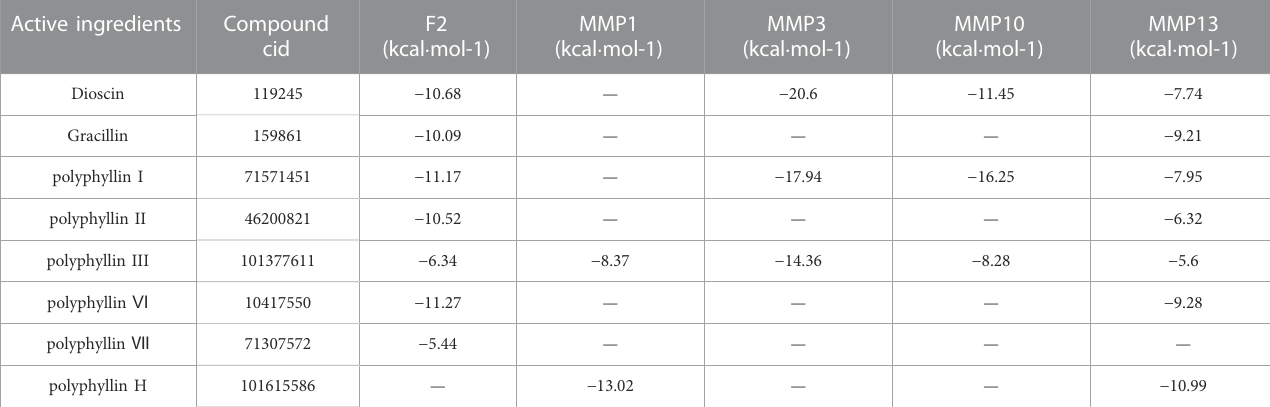
TABLE 4 Molecular docking results between the active ingredients of Chonglou and the hub genes. Active